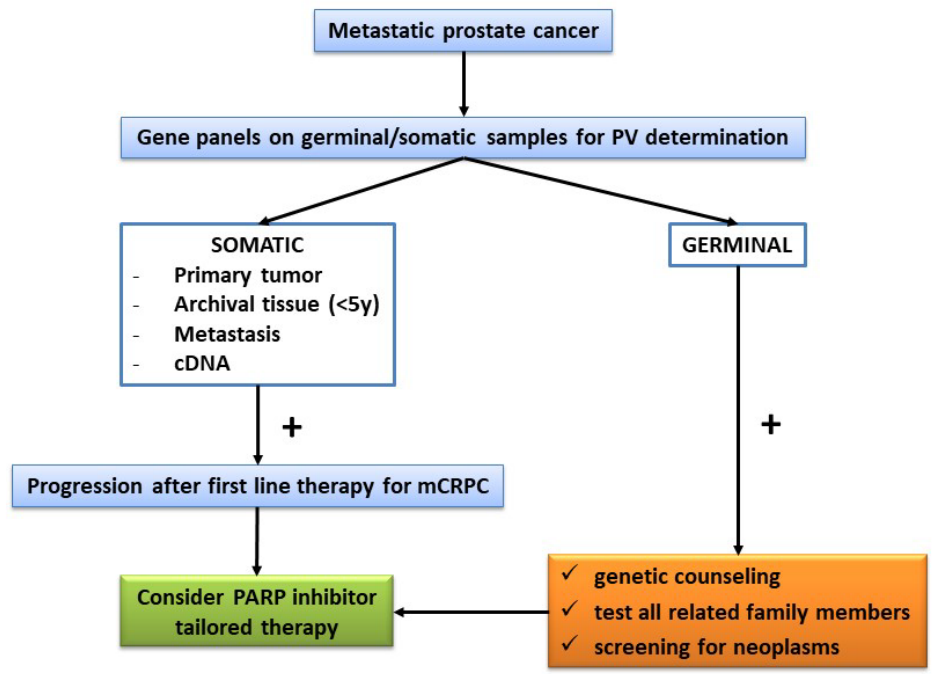
Figure 2. Flow chart on the use of HRR determination and PARP inhibitor strategy in metastatic prostate cancer patients.